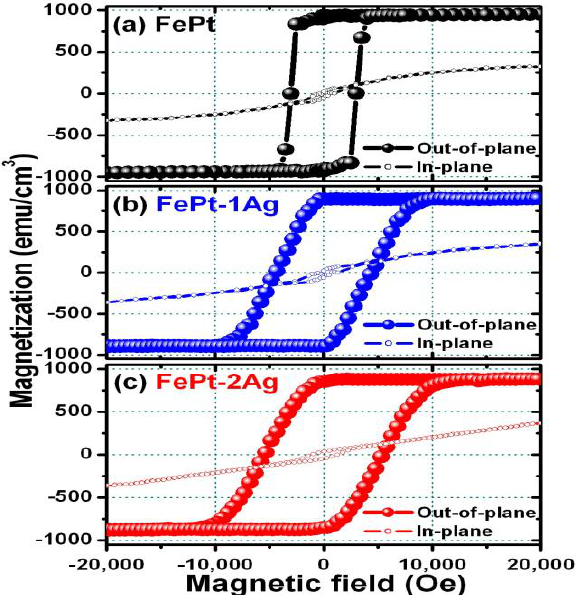
Figure 2. Out-of-plane and in-plane magnetization curves for the [Fe/Pt] 18 multilayer films ( a ) without and with insertion of ( b ) a single and ( c ) two ultrathin Ag (0.5 nm each) nanolayers denoted as FePt–1Ag and FePt–2Ag, respectively. The magnetic field was applied in the out-of-plane direction (full symbols, ●) and in the in-plane direction (open symbols, o) to the film, respectively. Table 1. Out-of-plane coercivity ( H c ﬩ )saturation magnetization ( M s ﬩ ), remanent magnetization ( M r ﬩ ), remanent squareness ratio ( M r ﬩ / M s ﬩ ), and uniaxial magnetic anisotropy energy ( K u ) values for the [Fe/Pt] 18 multilayer films without and with the insertion of a single and two ultrathin Ag (0.5 nm each) nanolayers.